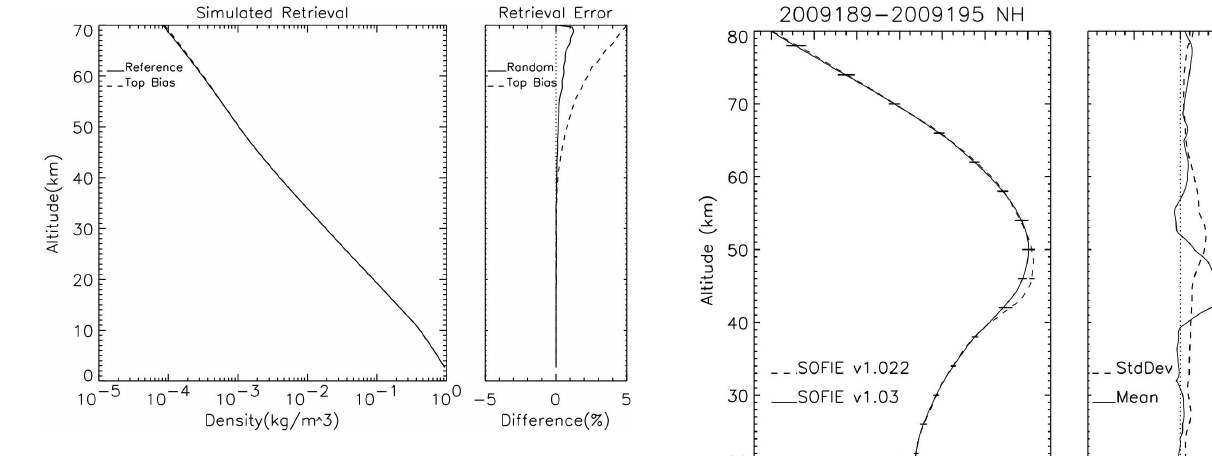
Fig. 26. Same as Fig. 25 except impact on retrieved density from random pointing error of 0.02arcsec and top boundary refraction angle error of 5%.